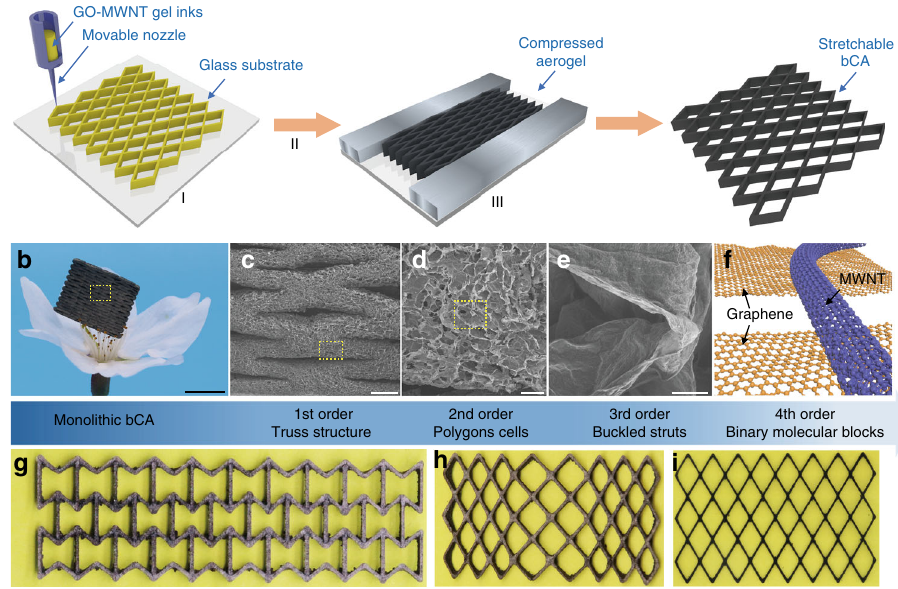
Fig. 1 Design and hierarchical architecture of synergistic bCAs. a Schematic illustration of the hierarchical synergistic assembly for fabrication of stretchable bCAs through 3D printing (I) followed by freeze-drying (II) and pre-buckled reduction (III). b A digital photograph of ultralight bCAs with density of 5.7 mg cm − 3 fl oating on a fl ower. c – f SEM images of quaternary structure of bCAs across multi-size scales. g – i Printed lattices by design with negative ( − 0.3, g ), positive ( + 0.5, h ), and nearly zero Poisson ratio ( i ). Scale bars, 5 mm ( b ), 500 μ m ( c ), 100 μ m ( d ), and 5 μ m ( e